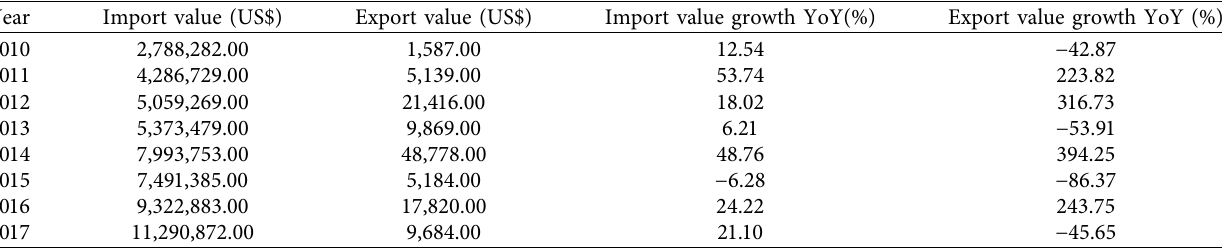
Table 10: Fish and crustaceans, mollusks, and other aquatic invertebrates’ import and export value (US$) and value growth, YoY (%) in Nepal, YoY � year over